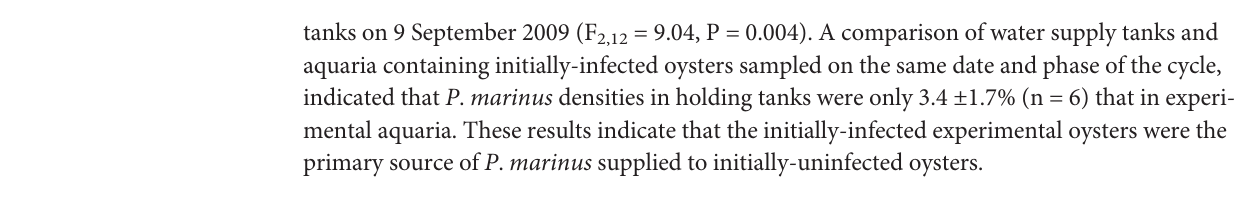
PLOS ONE | DOI:10.1371/journal.pone.0116223 February 11,